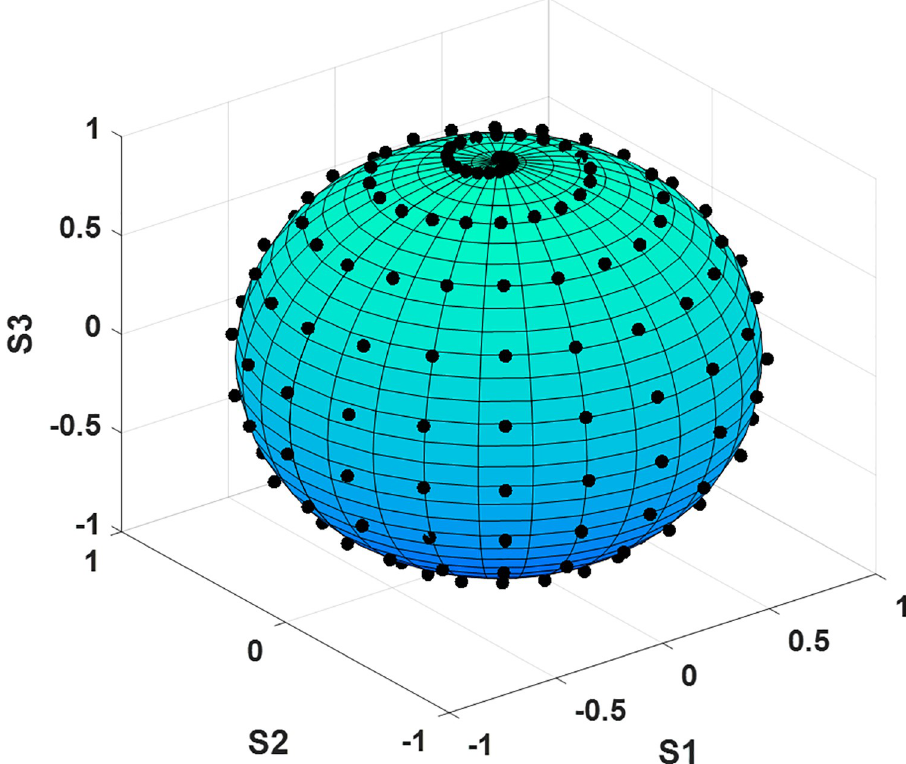
Fig 4. Poincare´ sphere showing the location of the input polarizations (N = 200) used to study the dependence of the input polarization on the DoP-based images contrast.